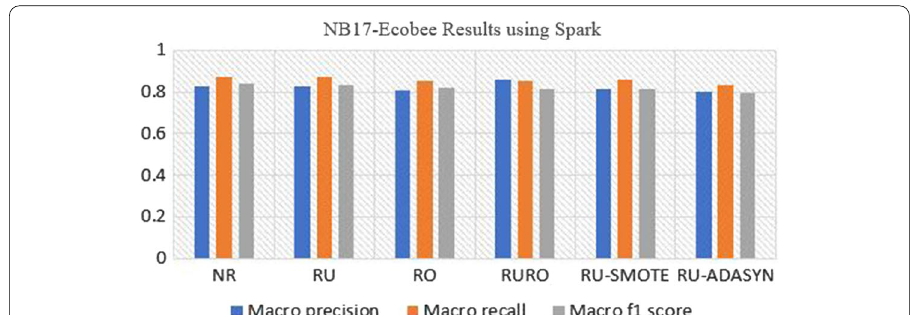
Fig. 13 ANN classification results for NB17-Ecobee on AWS with Spark for various resampling